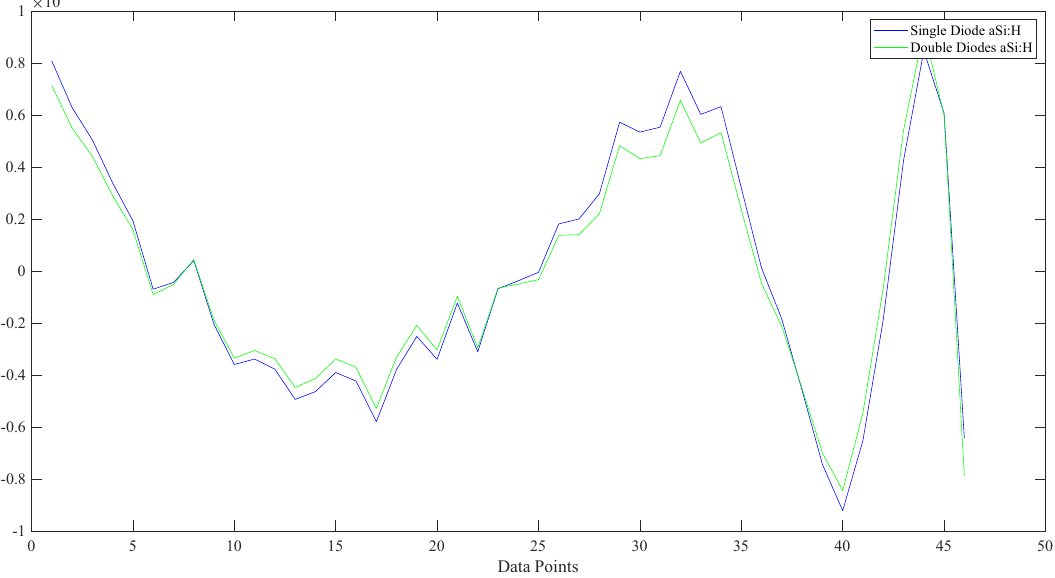
Figure 12. Error vs. data points for single diode and double diodes—amorphous silicon photovoltaic cell.